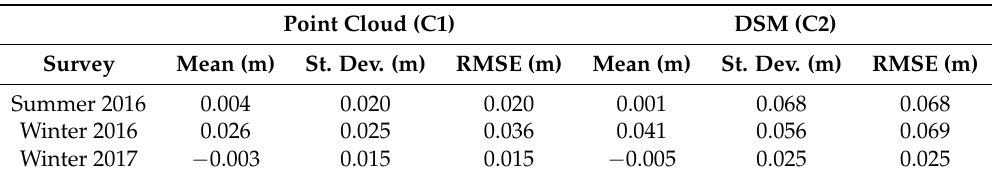
Table 3. Statistics of the winter and summer comparisons between the photogrammetric products and data from the